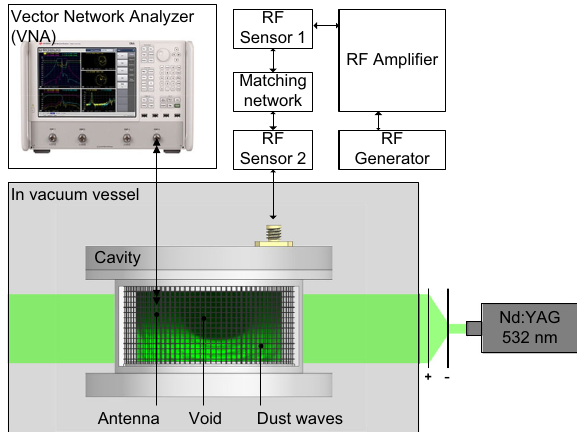
Fig. 2 A schematic overview of the experimental setup. The microwave cavity con fi ned the argon-hexamethyldisiloxane discharge used for growing dust grains in vacuum, where the grey box de fi nes the elements that were located inside the vacuum. The RF system supplied electrical power to the discharge, where the RF generator and ampli fi er provided continuous power to the matching network which ensured optimal power transfer to the plasma. The RF power was measured using power sensors. Meanwhile, the plasma response was monitored by the Vector Network Analyzer, and the dust grains were observed by capturing scattered laser light on a high- speed camera. The green laser beam (continuous power, Nd:YAG, wavelength 532 nm) was expanded in the axial direction of the cavity by two cylindrical lenses, which allowed the creation of a laser sheet (indicated by bright green area) that entered and left the cavity through two slits in the cavity ’ s side walls.